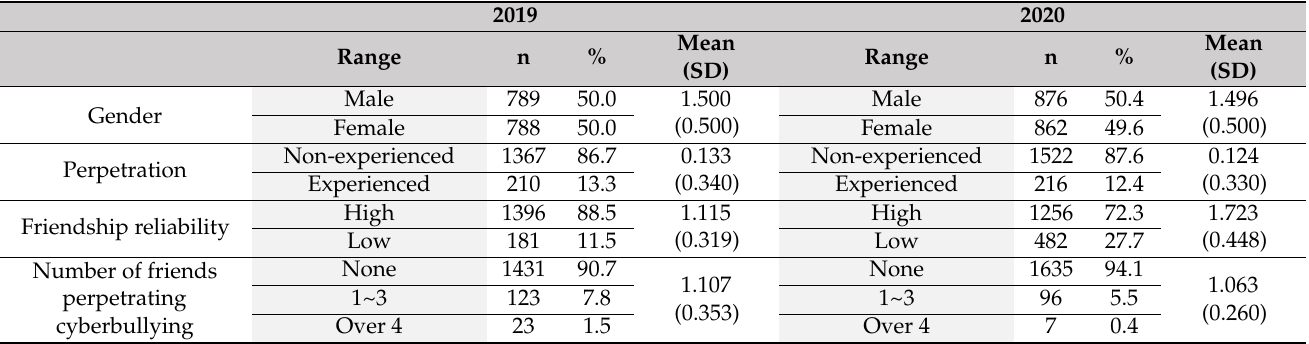
Table 2. Descriptive statistics for the variables of